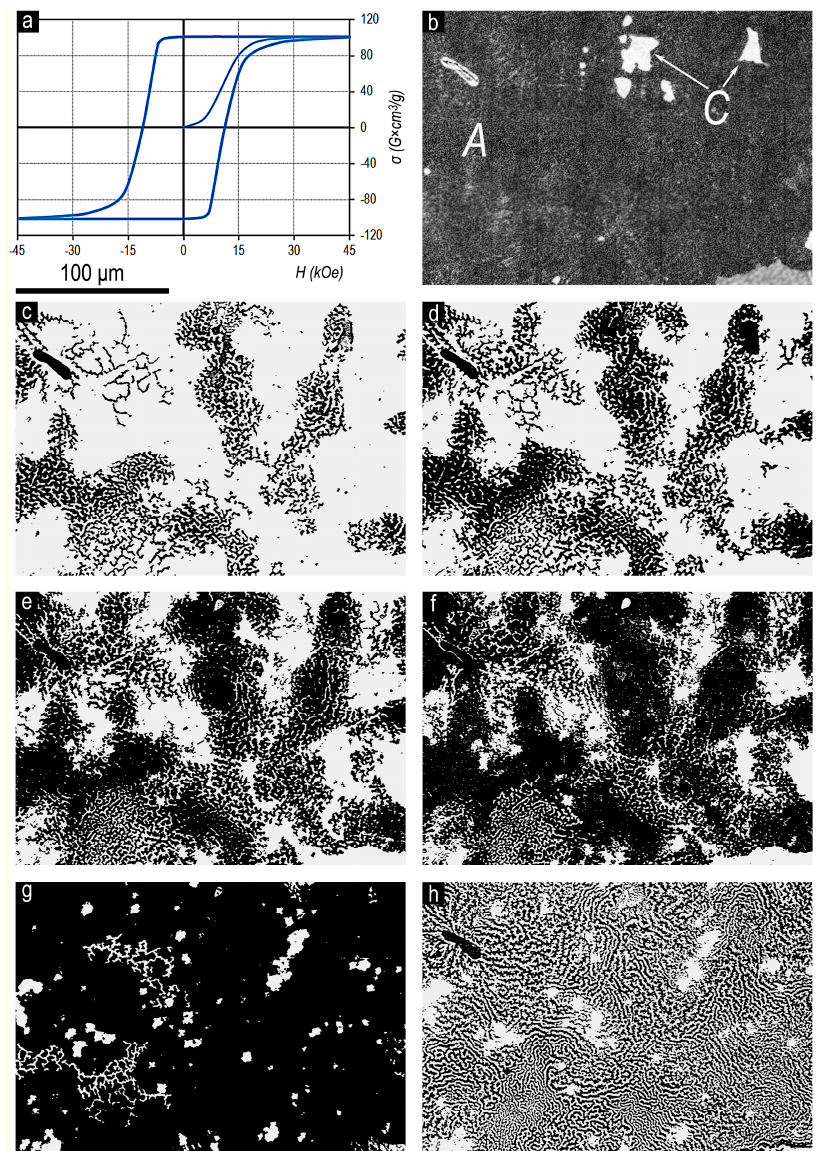
Figure 2. ( a ) Magnetization curve (from the OFVP-demagnetized state) and major magnetic hysteresis loop (without taking into account the demagnetizing factor N = 1 / 3), ( b ) microstructure on the basal plane of the pseudo-single-crystal Sm 0.85 Zr 0.15 (Co 0.702 Cu 0.088 Fe 0.210 ) 6.0 sample, ( c – h ) surface domain structure corresponding to area ( b ) of the sample upon progressive magnetization reversal from the magnetic saturation state with the opposite applied field ( c ) 4.5, ( d ) 6, ( e ) 8, ( f ) 10.5, and ( g ) 18 kOe; Kerr e ff ect, easy magnetization axis is perpendicular to the image plane. ( h ) The domain structure of sample in the OFVP-demagnetized